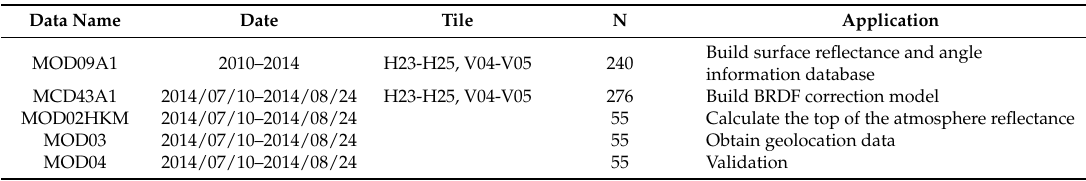
Table 2. Moderate-resolution imaging spectroradiometer (MODIS) images used for aerosol optical depth (AOD) retrieval in this study.